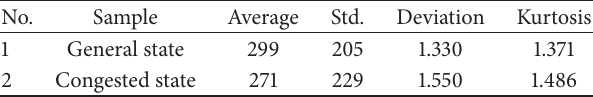
Table 2: Results of statistical analysis on the fixation duration.